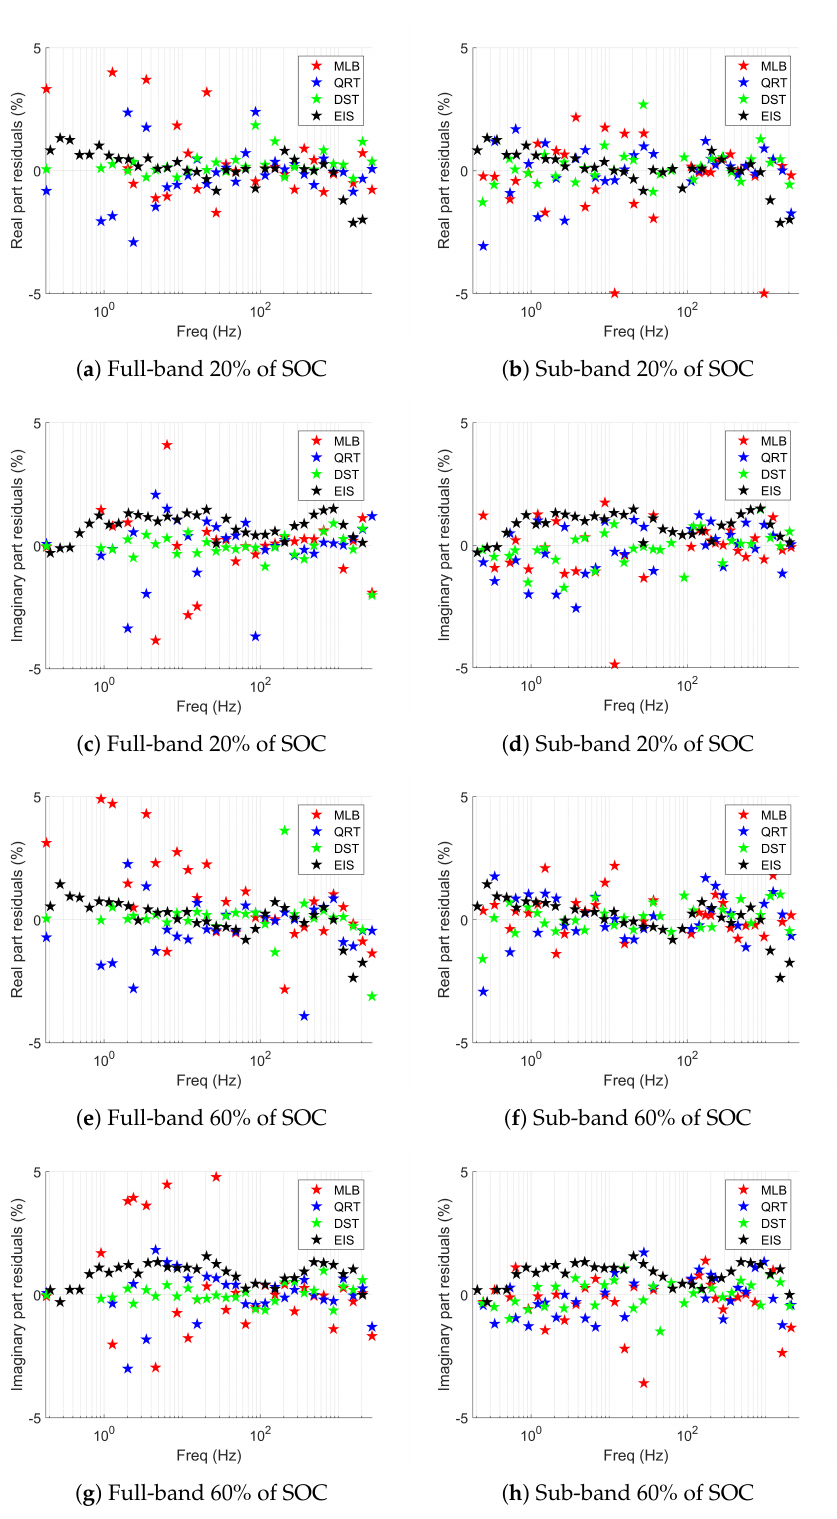
Figure 8. K–K compliance test residuals from impedance measurements at 20% and 60% of